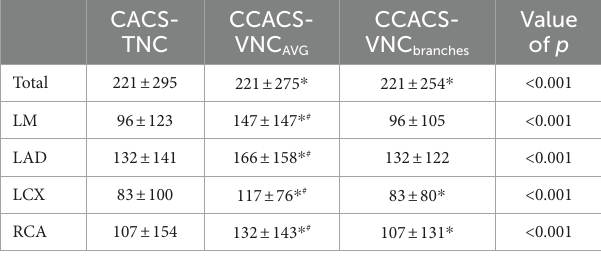
TABLE 3 Comparison of CACS-TNC, CCACS-VNC AVG , and CCACS- VNC branches .